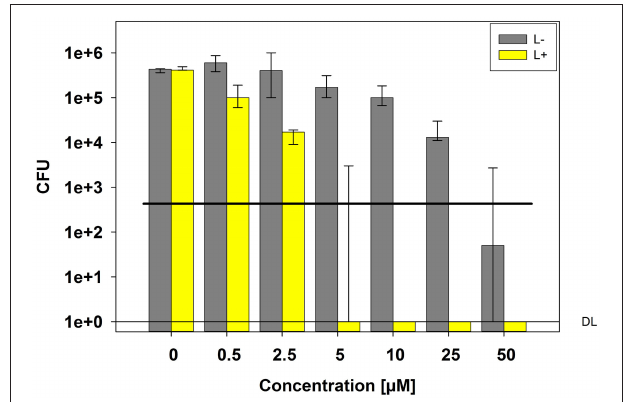
FIGURE 1 | Phototoxicity test with C. albicans and TMPyP. C. albicans cells were incubated with different concentrations of TMPyP for 15min. The samples were irradiated with blue light and an energy dose of 12 J/cm ² (L + ). Non-irradiated controls (L-, gray bars) were conducted with C. albicans alone (0 µ M) or with C. albicans and TMPyP (0,5–50 µ M). CFU assays were performed after irradiation and CFU were determined after 12h of incubation. Bars represent the medians, minima and maxima of three independent experiments ( n = 3). The black line marks a CFU-reduction of 3 log 10 (99.9%) as compared to the untreated control (0 µ M TMPyP, L-). DL represents the detection limit.